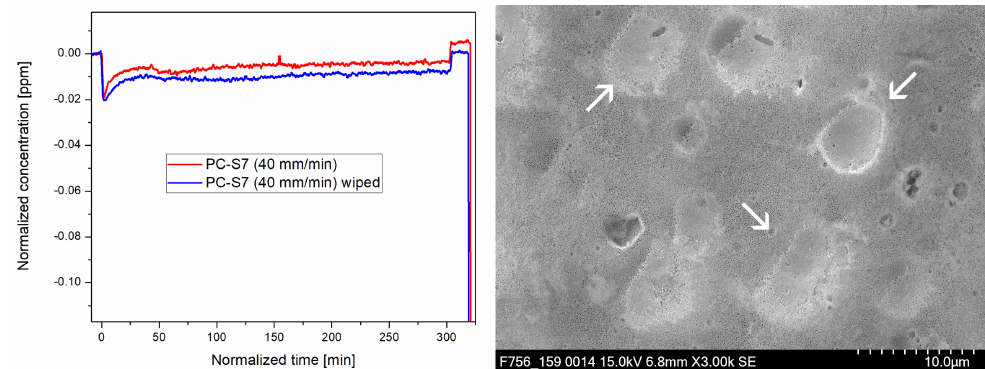
Figure 8. Comparison of NO reduction in the anodized layer impregnated with PC-S7 (40 mm/min) before and after wiping ( left ) and SEM micrograph of the surface impregnated with PC-S7 dispersion and wiped with a cloth ( right ). Residual titania deposits are still present in etching dimples and marked by arrows. Table 3. NO degradation rate and rPCE values of the impregnated anodizing layers. Sample Code NO Degradation